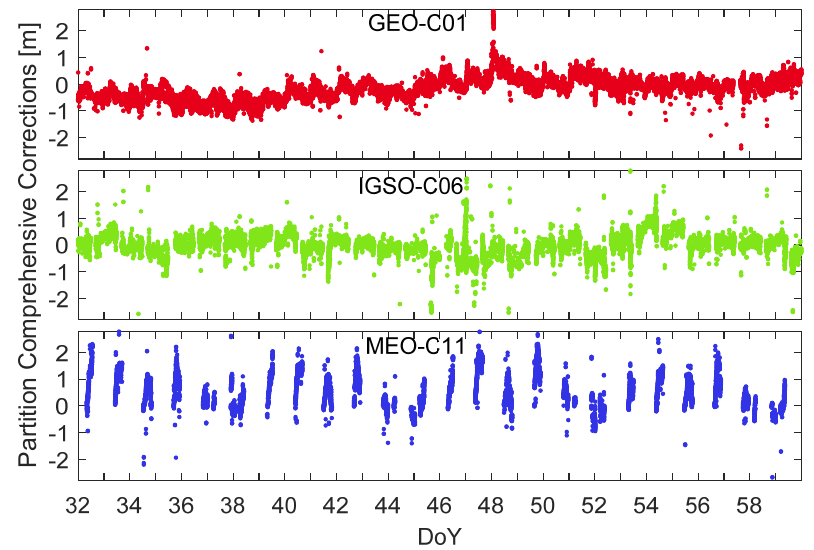
Figure 5. One-month BDS real-time partition correction time series for C01, C06, and C11 in partition No. 6. Table 3. Statistics of BDS real-time partition correction time series for C01, C06, and C11 (in meter).